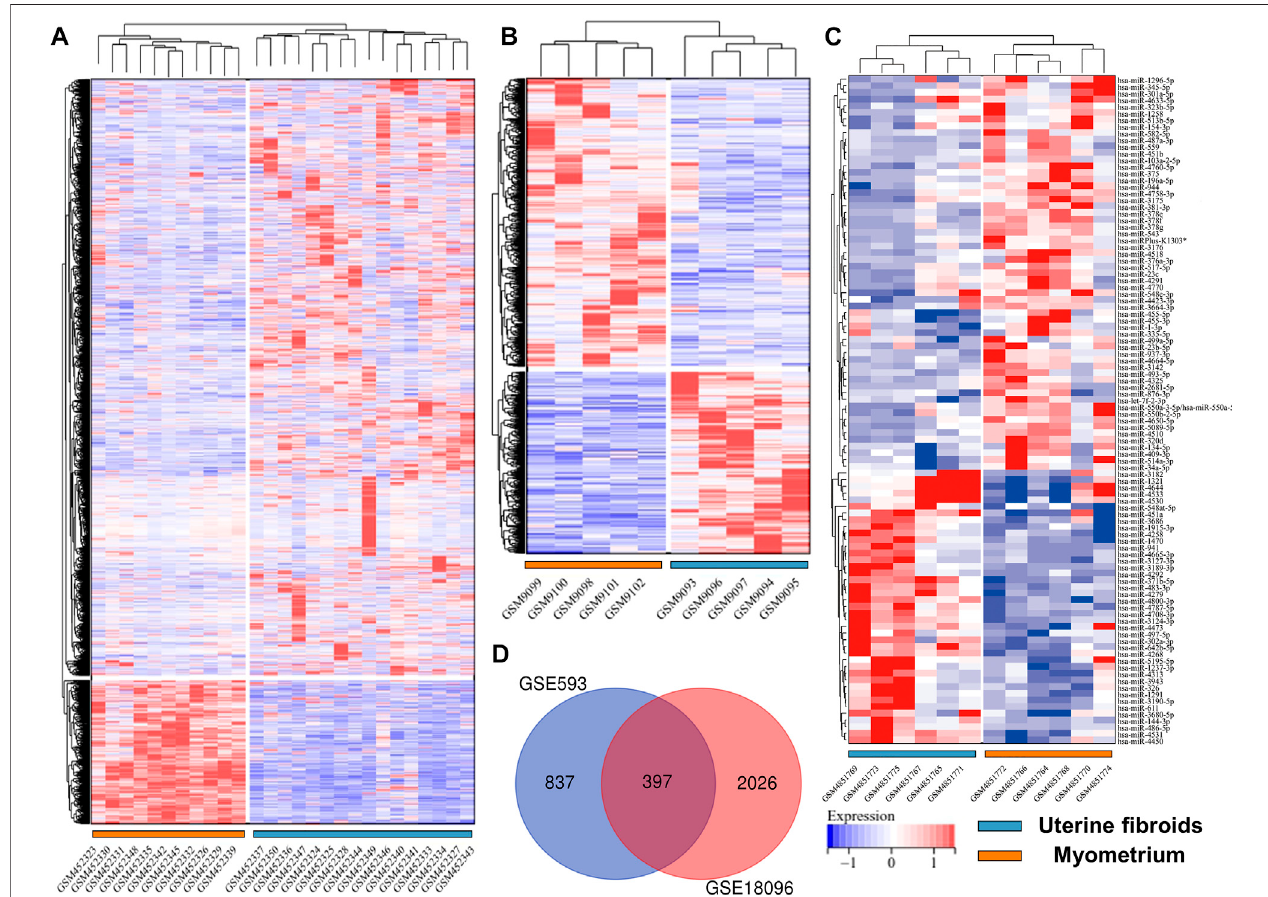
FIGURE 2 | Heatmap of (A) GSE18096. (B) GSE593, (C) GSE159959. (D) Venn diagram of screening DEGs form mRNA expression pro fi le.